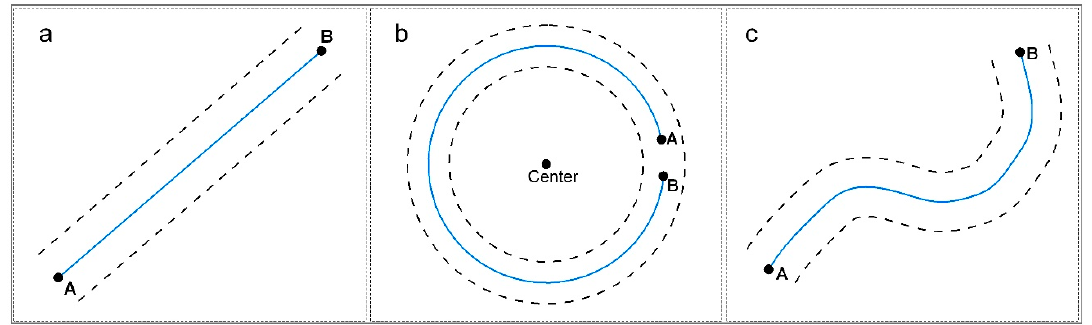
Figure 1. Major line feature types for automated guidance systems including straight ( a ), circular ( b ), and freeform curve ( c ).